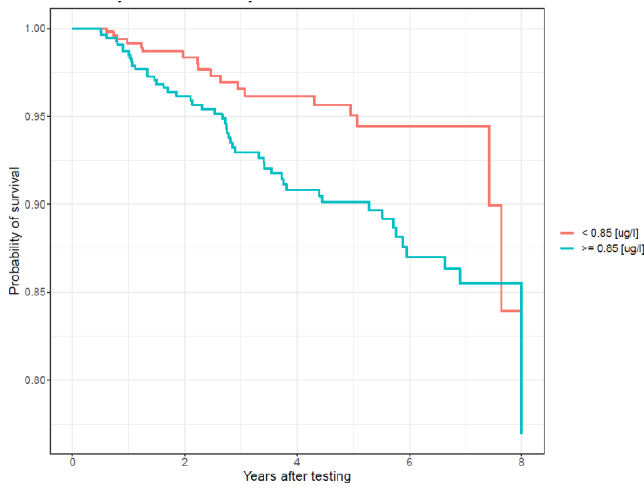
Figure 1. Probability of breast cancer-free survival stratified by median total blood arsenic levels (µg/L).